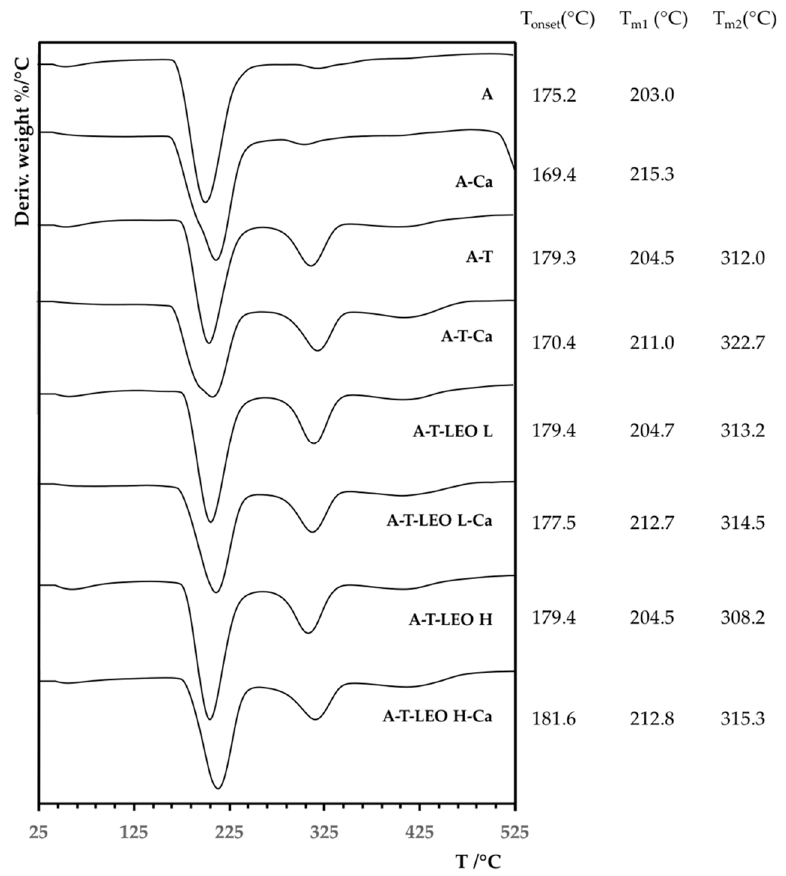
Figure 4. Derivative thermo-gravimetric analysis (DTGA) curves of the obtained films. The embedded table gives the values of the onset and peak temperatures.